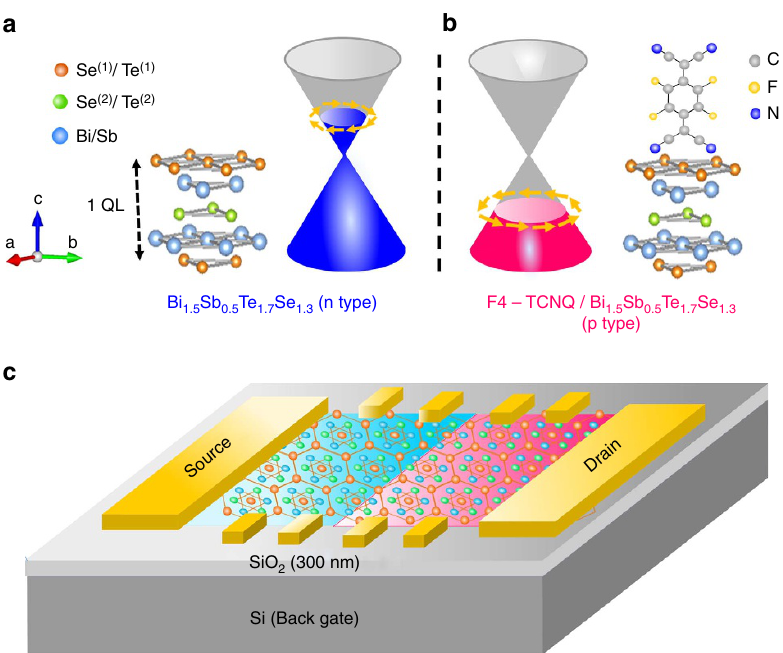
Figure 1 | Schematic view of TPNJ device. ( a , b ) Electronic structure of BSTS and F4-TCNQ/BSTS and ( c ) topological p-n junction device. To make a local carrier tuning on the 3D-TI thin film, F4-TCNQ molecules are partly deposited on the n-type BSTS thin film